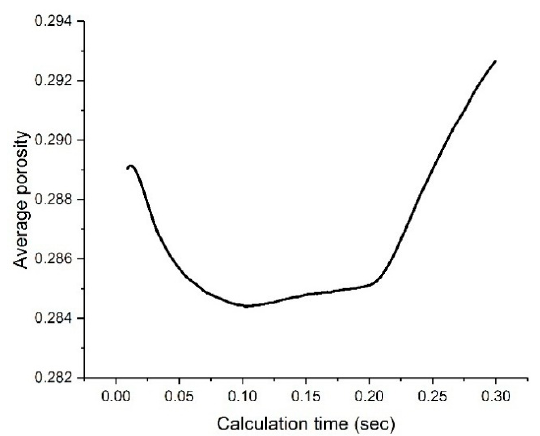
Figure 17. Evolution of mean porosity based on measurement region.